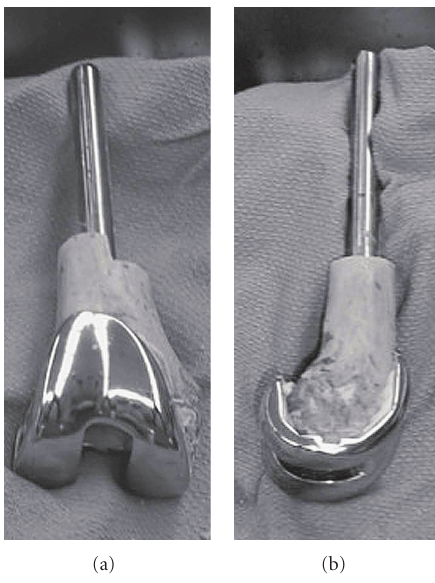
Figure 3: Intraoperative pictures of allograft-prosthesis composite (APC), AP view (a) and lateral view